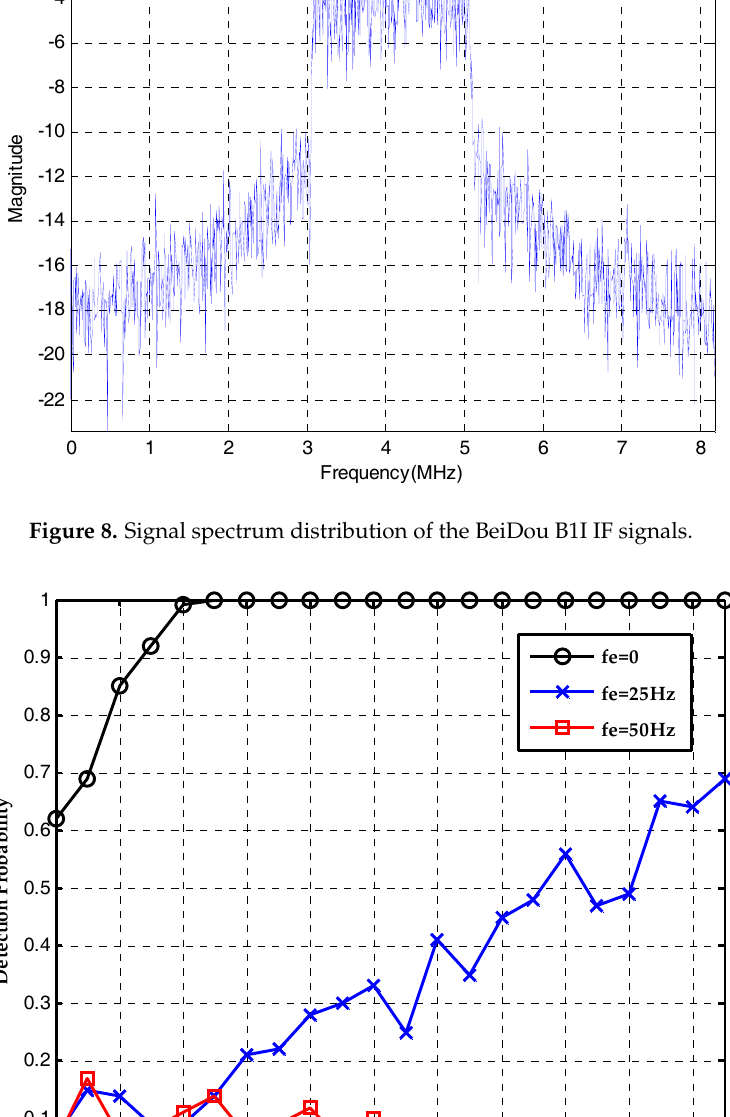
Figure 10. Detection probabilities of the DCML bit synchronization algorithm under the CN0s of 20~40 dB-Hz and different frequency deviations. Finally, the performances of two algorithms are compared with different frequency deviations. Figure 11 is the detection probability without frequency deviation. The conventional maximum likelihood method outperforms the proposed bit synchronization algorithm which has gain attenuation. Figure 12 is the detection probability with a frequency deviation of 25 Hz and the performances of two algorithms are about the same. Then, Figure 13 is the detection probability with a frequency deviation of 50 Hz. It is clear that the proposed bit synchronization algorithm